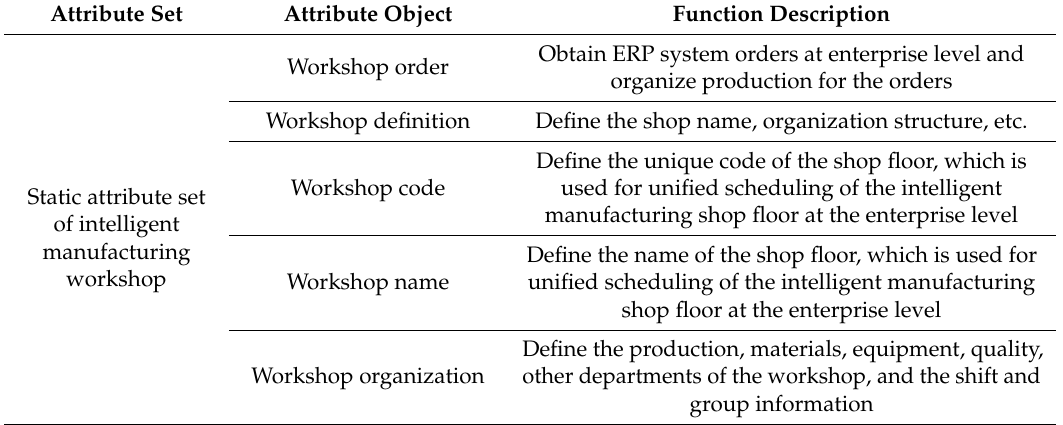
Table 1. Attribute objects and function descriptions contained by static attribute set and process attribute set of lithium ion battery intelligent manufacturing workshop.